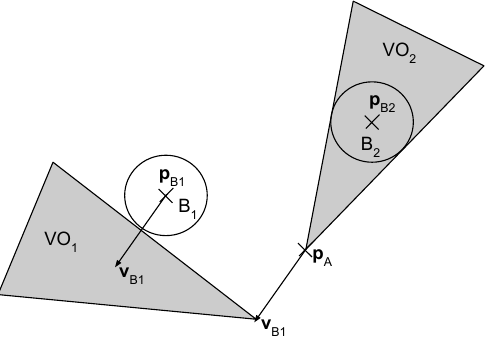
navigating an environment A with velocity v B1 and a static obstacle B 2 at p . B1 B2